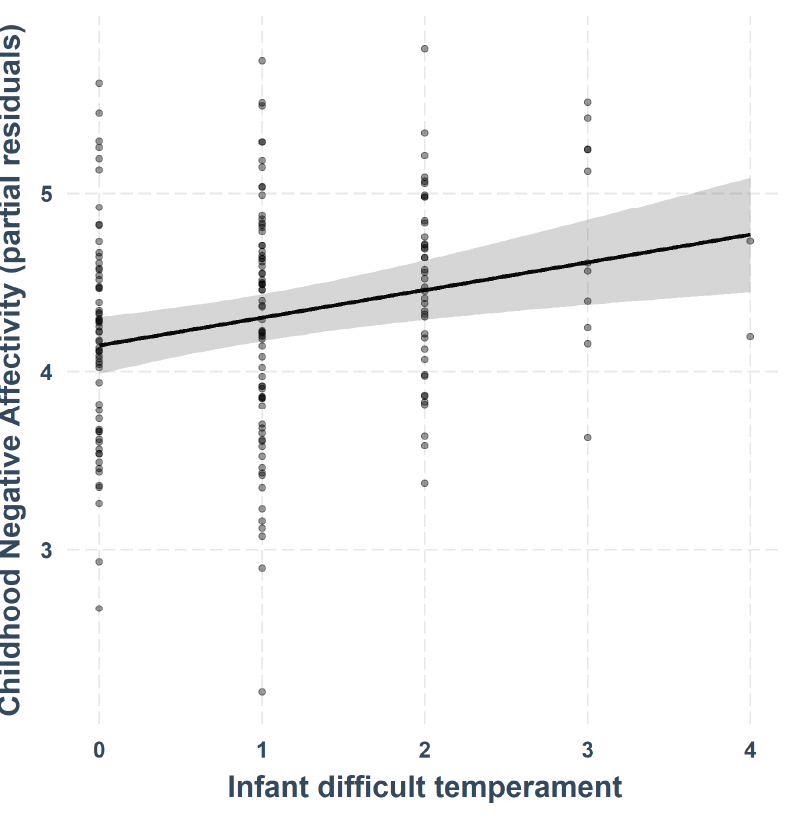
Figure 1. Association between difficult infant temperament and childhood Negative Affectivity (controlling for easy temperament, sex, GA at birth, IMD score and age at follow-up assessment).